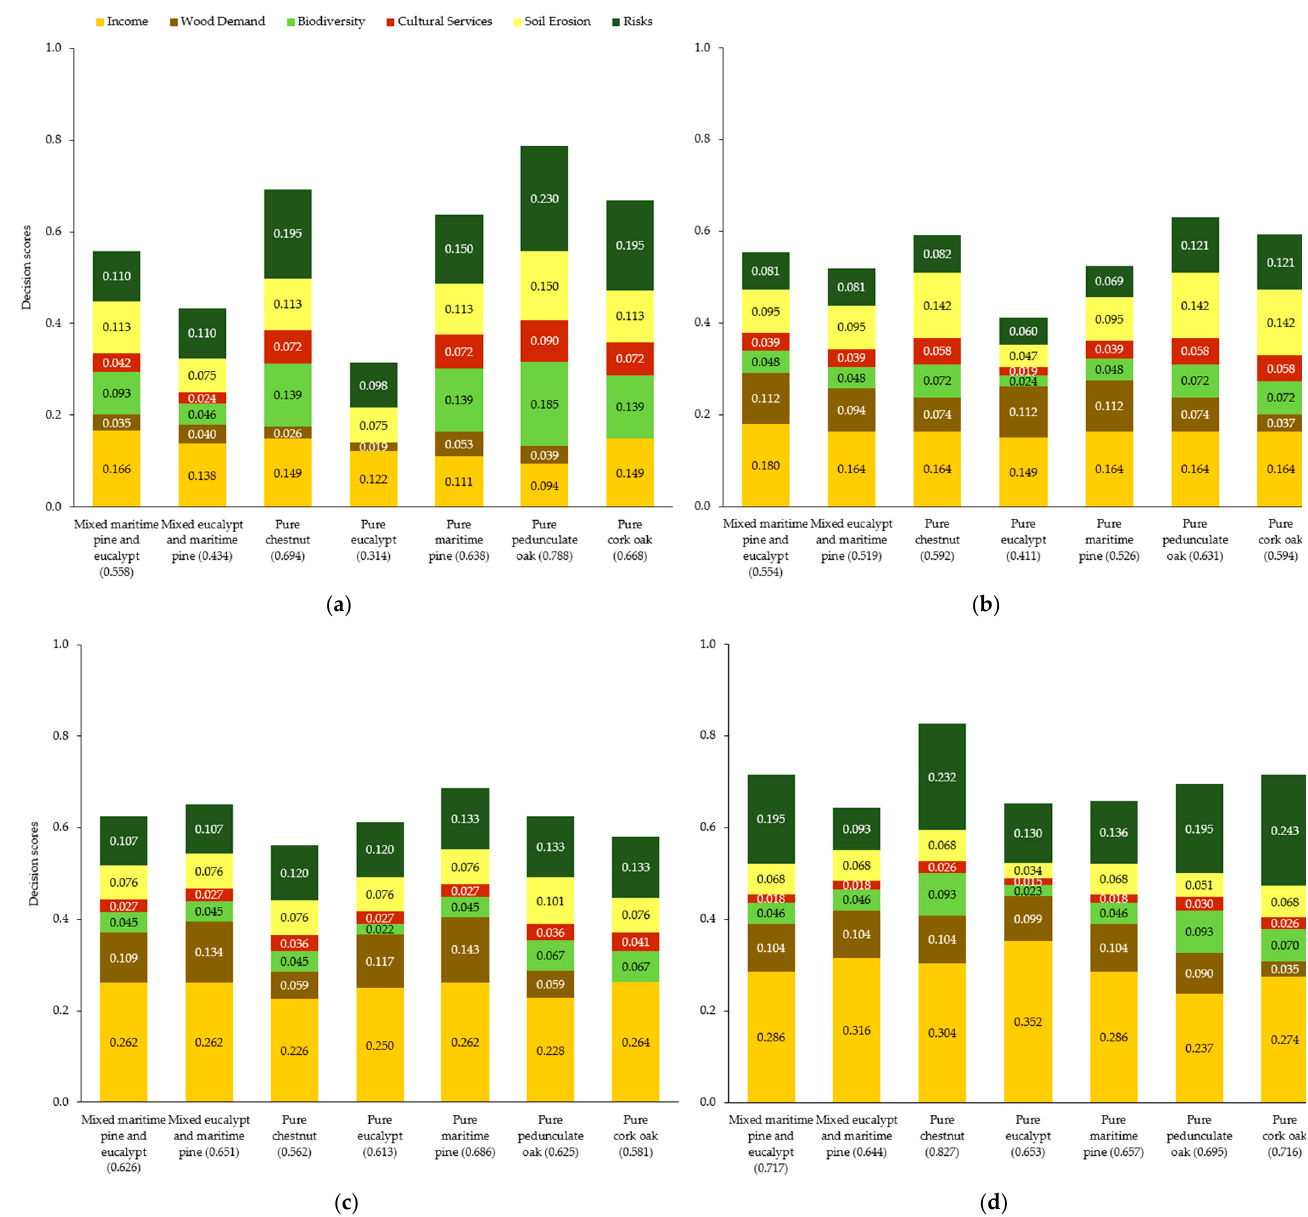
Figure 11. Contributions by criteria to alternative (FMM) performance as assessed by each interest group: ( a ) civil society; ( b ) forest owners; ( c ) market agents; ( d ) public administration.